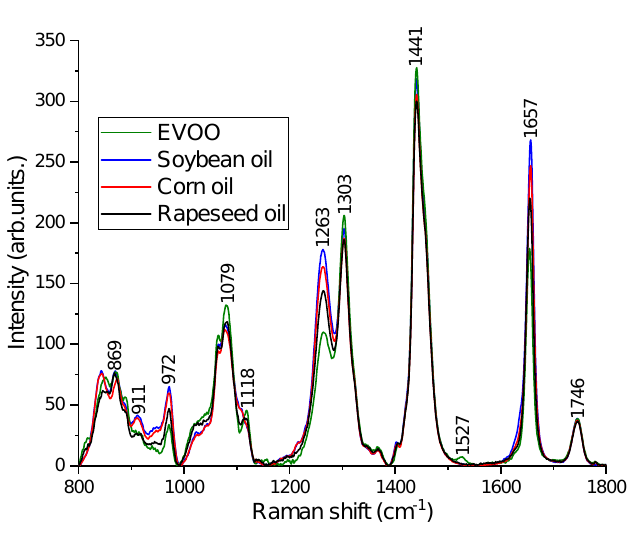
Figure 2. Pure Raman spectra of EVOO, soybean oil, corn oil and rapeseed